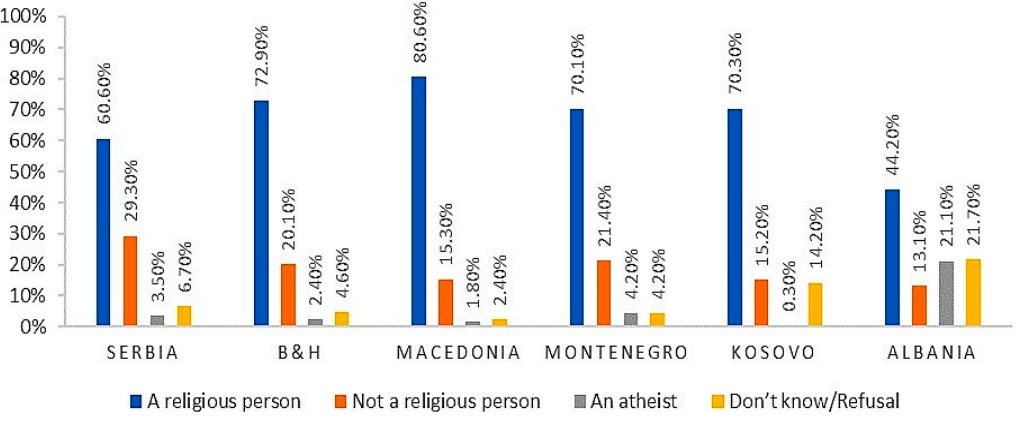
Figure 2. Religious self-declaration by country.